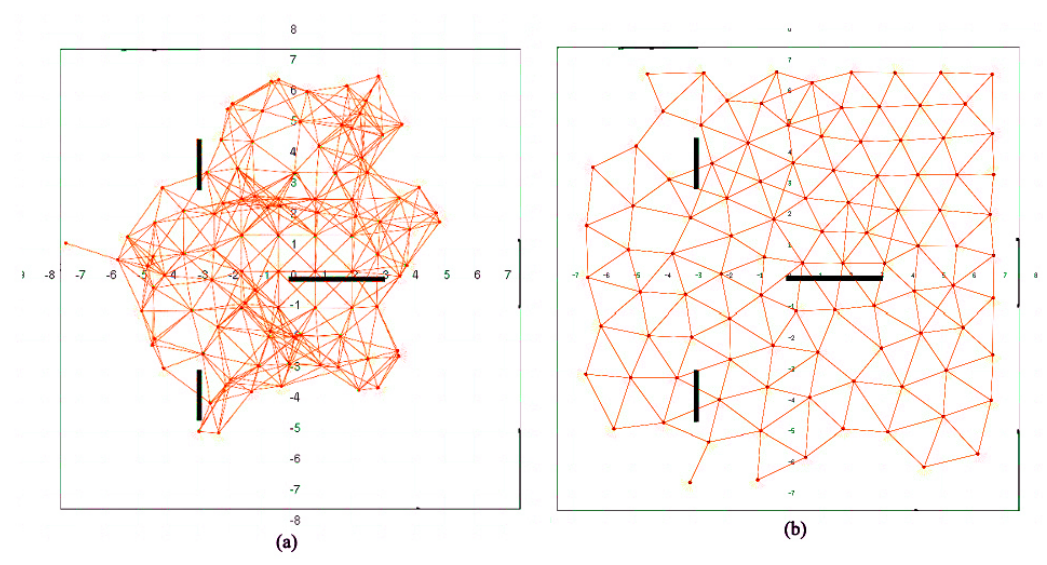
Figure 8. Deployment for 100 robots in an environment with obstacles using: ( a ) BDA; ( b )